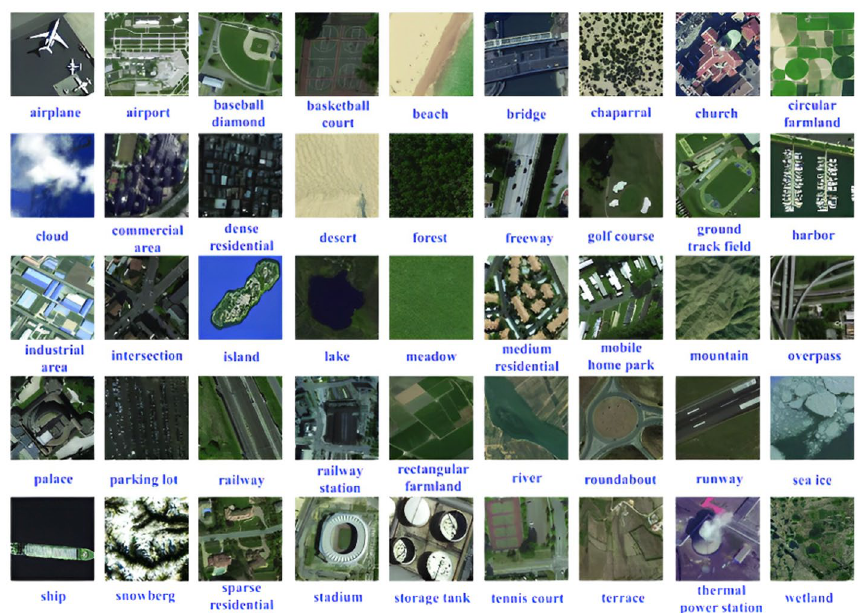
Fig. 7 The samples of NWPU